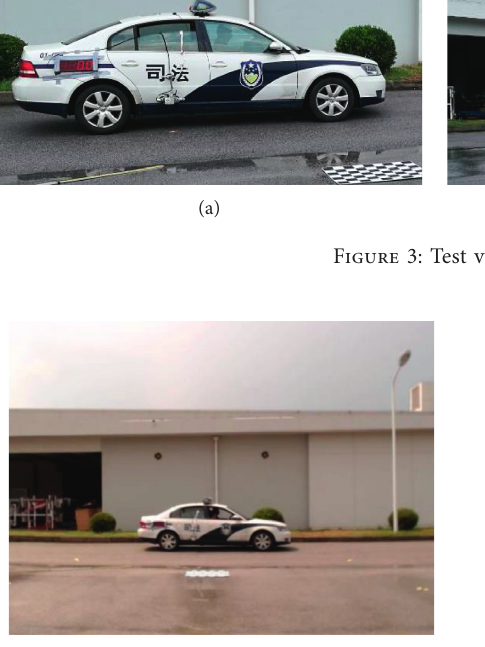
Figure 4: Original images taken by the video camera.